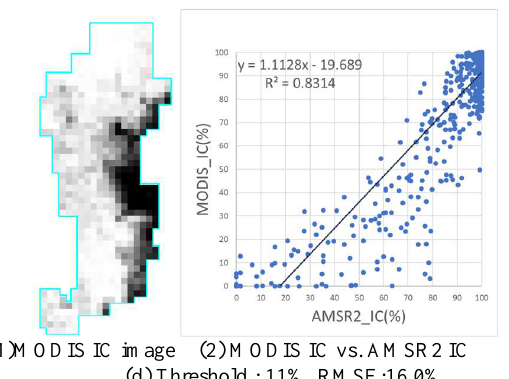
Figure 7. Relationship between MODIS IC and ASMR2 IC with he change of threshold level of MODIS